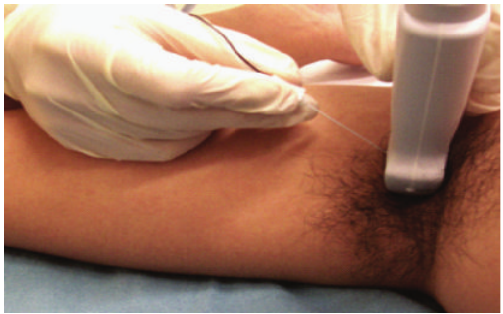
Figure 3: Ultrasound-guided axillary brachial plexus block. This is an example of an out-of-plane approach of the needle with respect to the